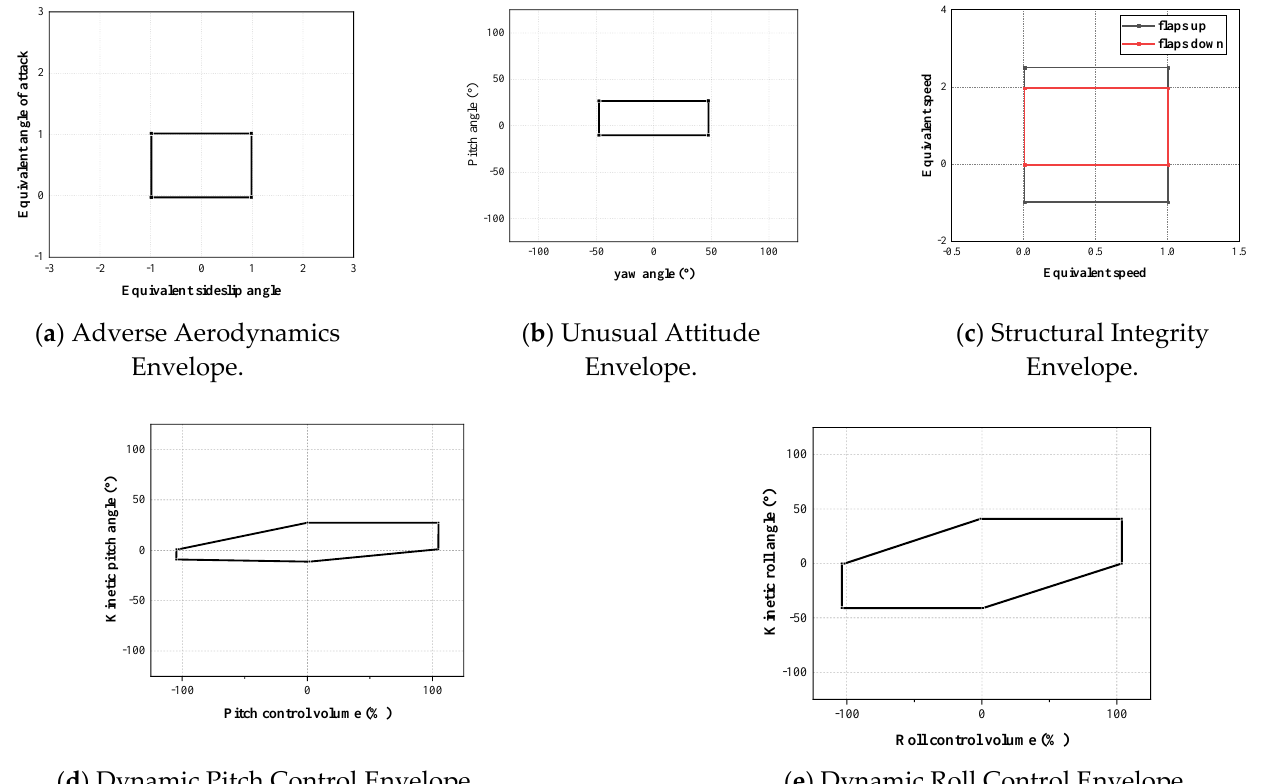
Figure 1. LOC envelope curve [10]. ( a ) Adverse Aerodynamics Envelope. ( b ) Unusual AttitudeEn- velope. ( c ) Structural Integrity Envelope. ( d ) Dynamic Pitch Control Envelope. ( e ) Dynamic Roll Control Envelope.